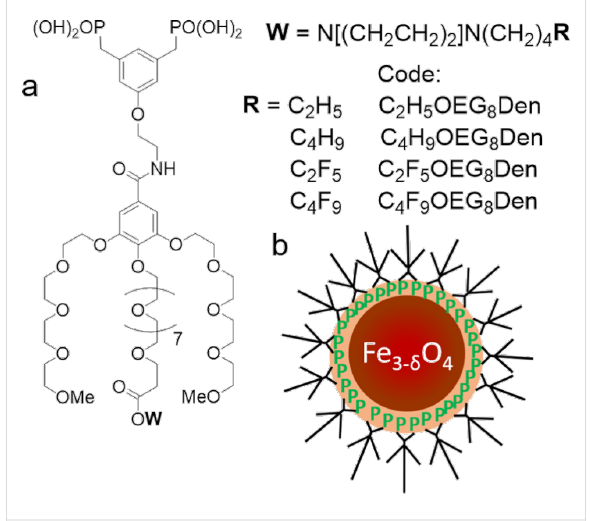
Figure 1: a) Molecular structure of the dendrons investigated (C n X 2 n +1 OEG 8 Den, X = F or H; n = 2 and 4); b) Schematic representa- tion of a dendronized IONP showing the anchoring of the bisphospho- nate function on the iron